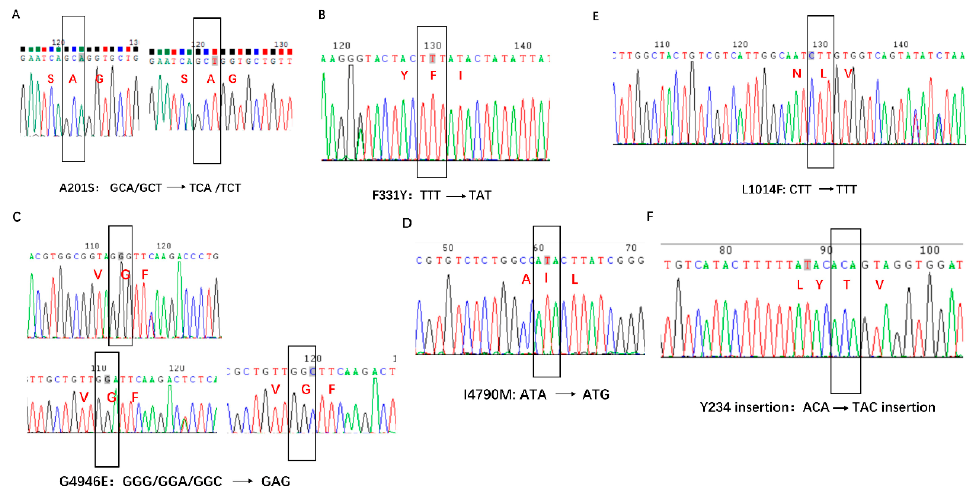
Figure 3. Representative chromatograms of the insecticide resistance mutations examined in Asian corn borer collected in 2019–2021 from China. Black wireframe indicates the site of the examined mutation in the DNA sequence and the nucleotide codon (amino acid) of the examined mutation in all tested samples: ( A ) for the A201S mutation; ( B ) for F331Y/W; ( C ) for the G4946E mutation; ( D ) for the I4790M mutation; ( E ) for the L1014F mutation; and ( F ) for the 234Y insertion.